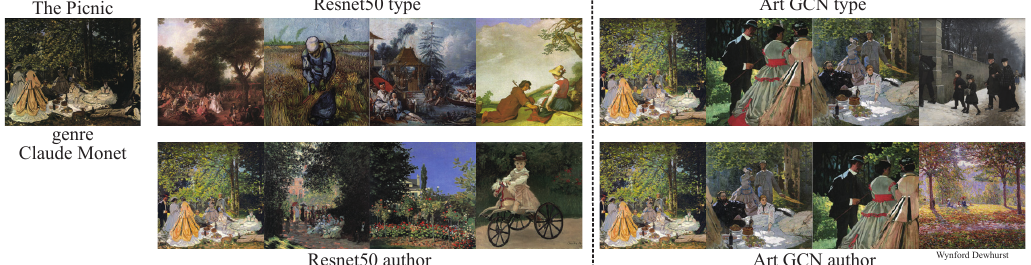
Figure 9. Similarity results for the painting The Picnic, by Monet,